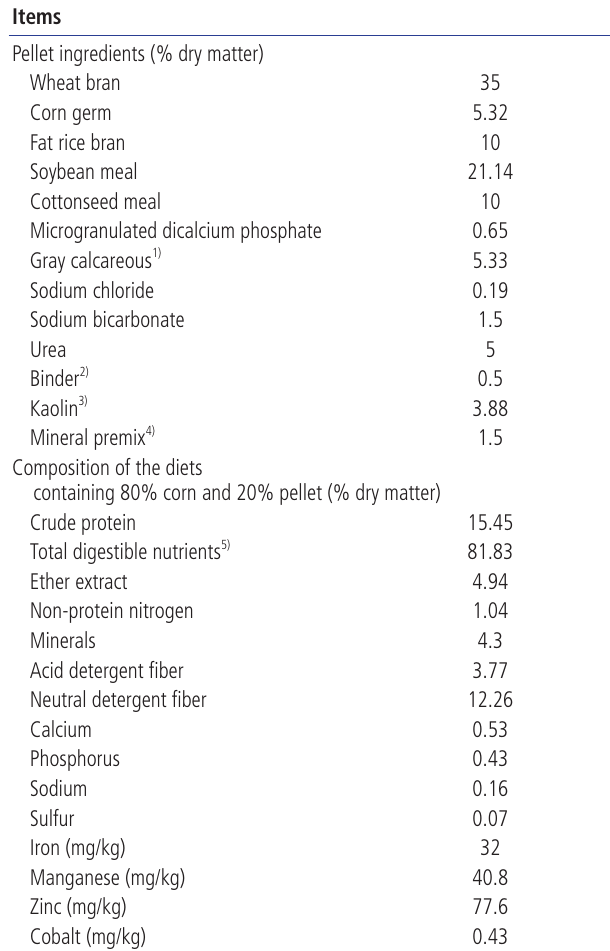
Table 1. Ingredients and composition of the